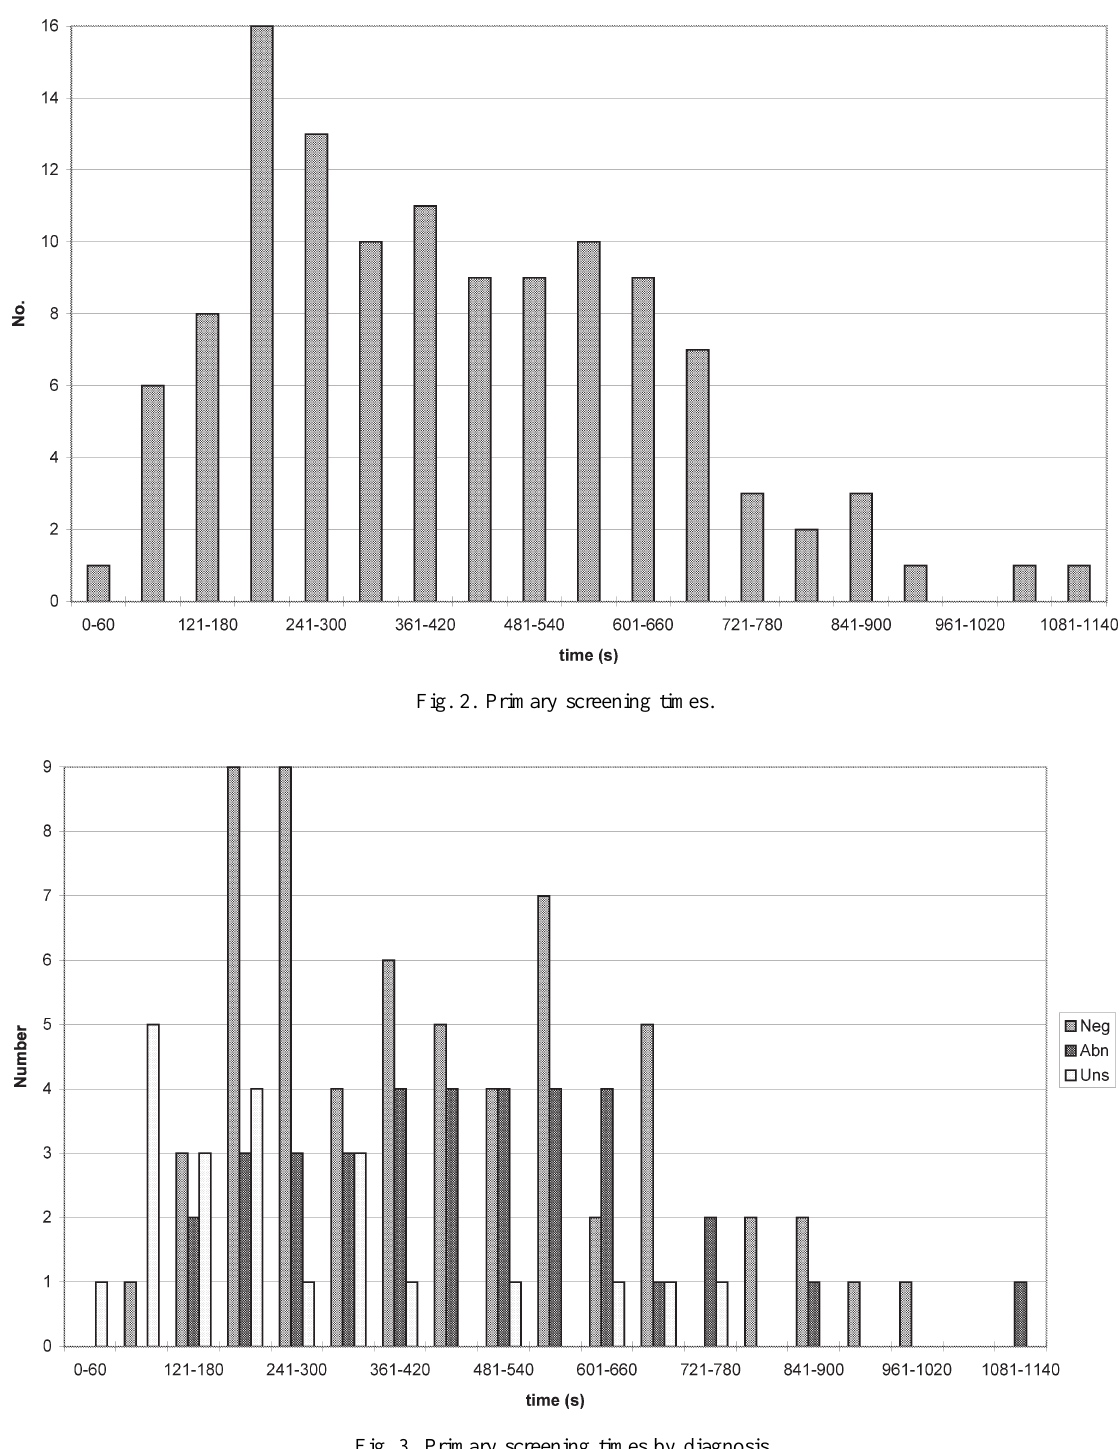
Fig. 3. Primary screening times by